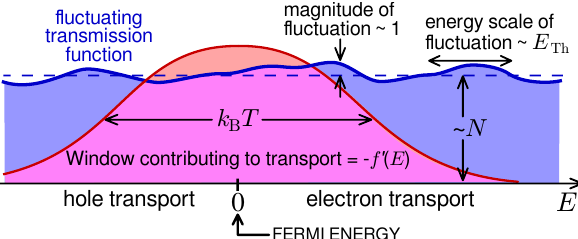
Figure 2: A sketch of the transmission of a a typical disordered or chaotic dot for large N . The transmission (blue curve) is of order N on average, but with fluctuations of order one, that is to say of order N 0 . The factor of − f (cid:48) ( E ) (red curve) is that given in Eq. (5). The transport properties are related to the product of these two functions, so that they are dominated by the transmission in an energy window of order k around the Fermi